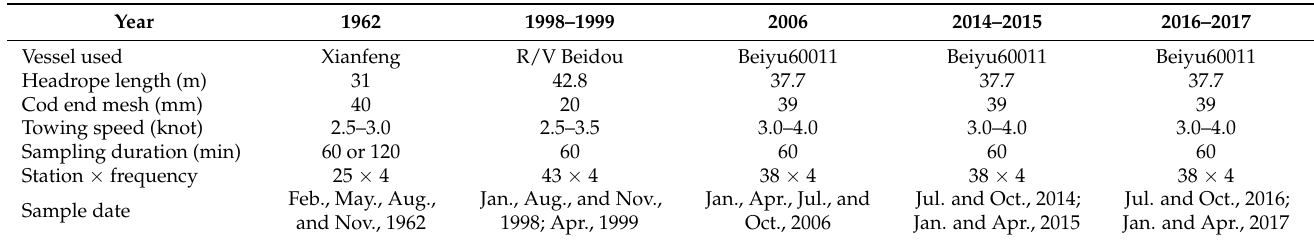
Table 1. Details of the fishery stock surveys in the Beibu Gulf.